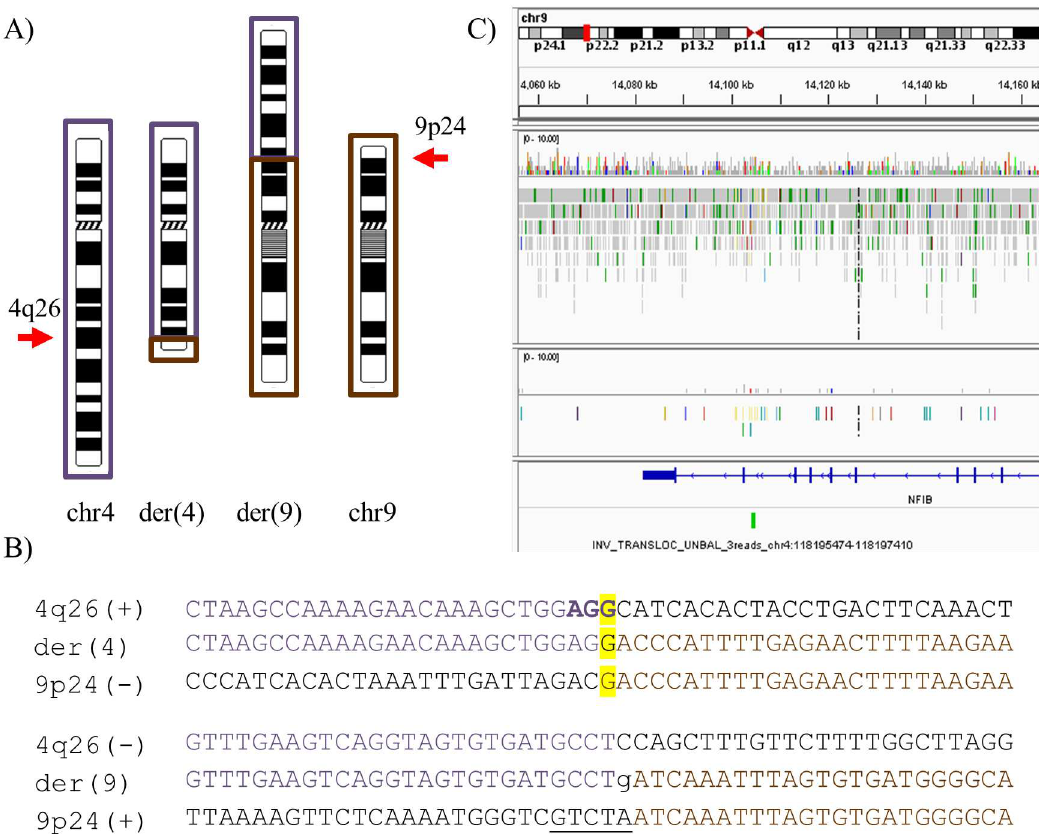
Fig 3. Summarized WG-MPS and Sanger sequencing results in Case 3. A) Partial ideograms showing the normal and derivative (der) chromosomes (chr) 4 (dark purple) and 9 (brown) (not to scale) in Case 3. 4q26 and 9p24 breakpoints are indicated by arrows. B) Derivative translocation junction sequences (middle line) and matching reference sequences (top and bottom lines) as identified by Sanger sequencing. Microhomology is highlighted in yellow, deleted sequences are underlined, duplicated sequences are in bold letters, and inserted sequences not aligning to either chromosome are in lower-case letters. C) IGV screenshot illustrating the der(9) breakpoint disrupting the NFIB gene within intron 10/10